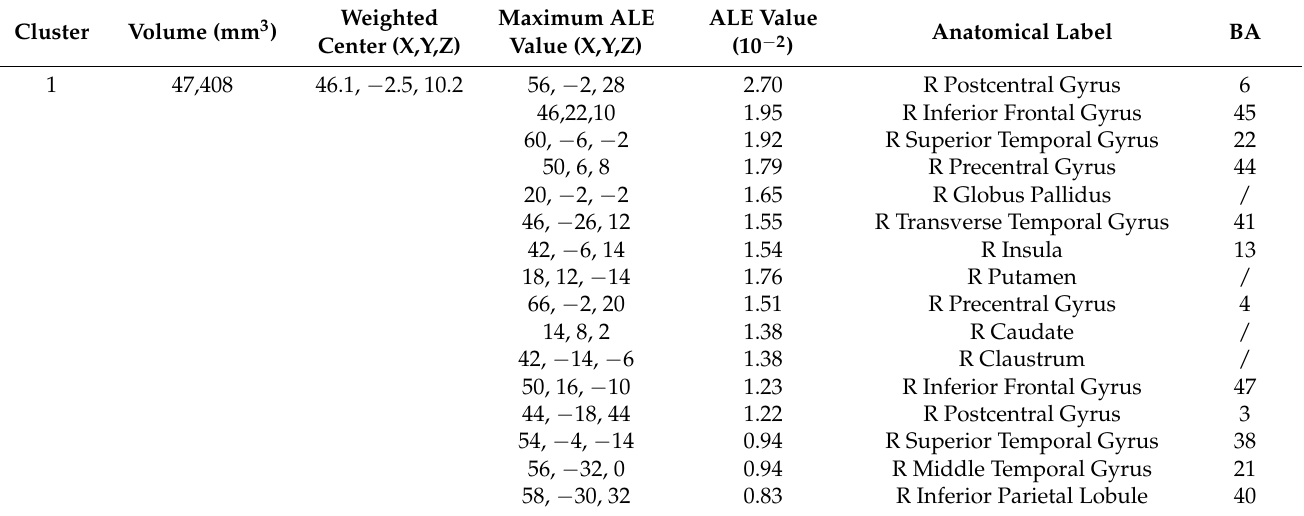
Table 3. PWS group clusters found by ALE